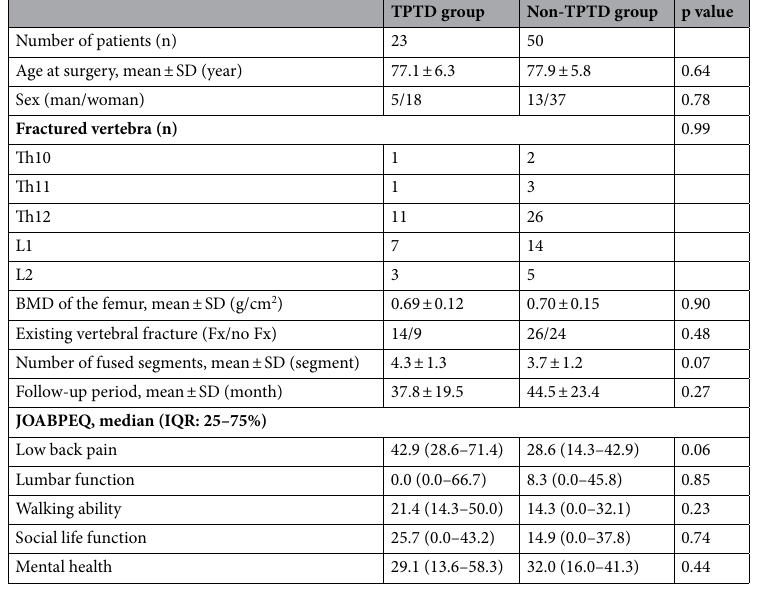
Table 1. Comparison of patient demographics. SD standard deviation, IQR interquartile range, BMD bone mineral density, Fx fracture, JOABPEQ Japanese Orthopaedic Association Back Pain Evaluation Questionnaire.